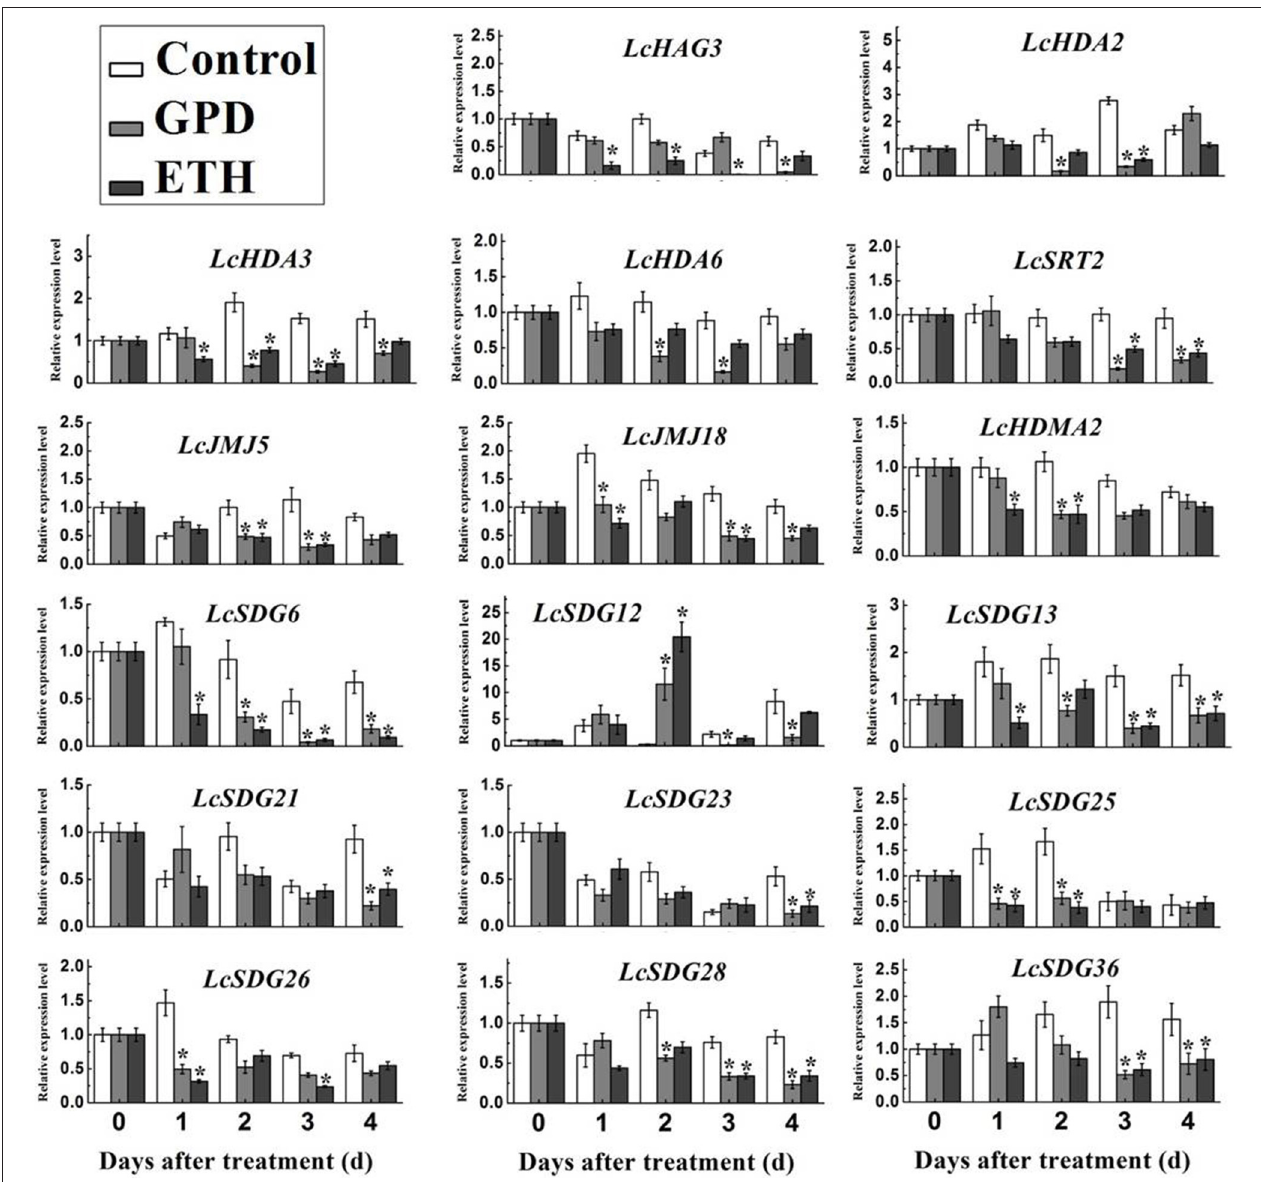
FIGURE 8 | Expression level of HMs in AZ cells during fruit abscission in litchi. GPD indicated Girdling Plus Defoliation (GPD) treatment and ETH indicated ethephon (ETH) treatment. qRT-PCR analysis was used. LcEF-1a was used as an internal control. Data shown are means ± SD. One-way ANOVA (Tukey-Kramer test) analysis was performed, and statistically significant differences ( P < 0.05) were indicated by